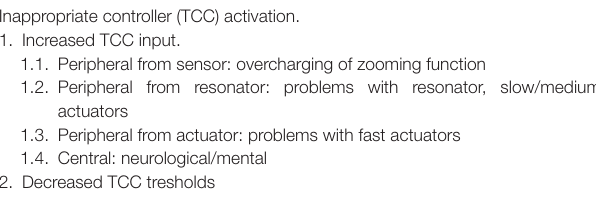
TABLE 1 | Pathophysiologic